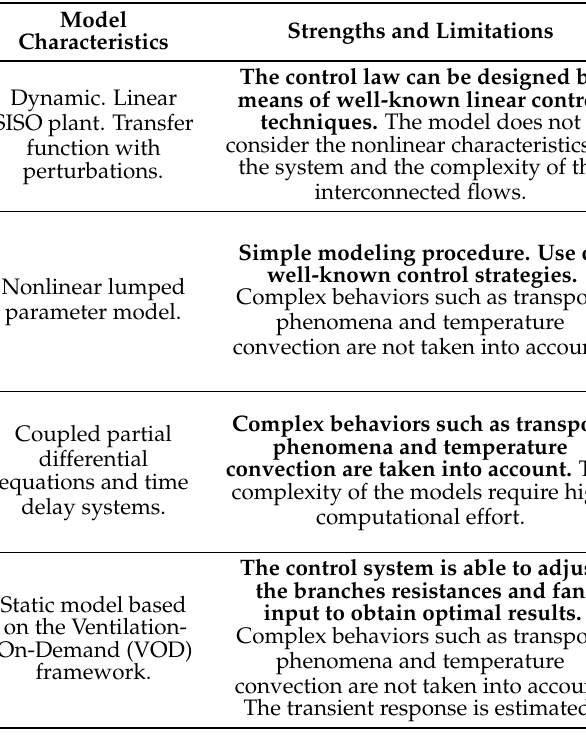
Table 1. Literature review on mine ventilation systems modeling and